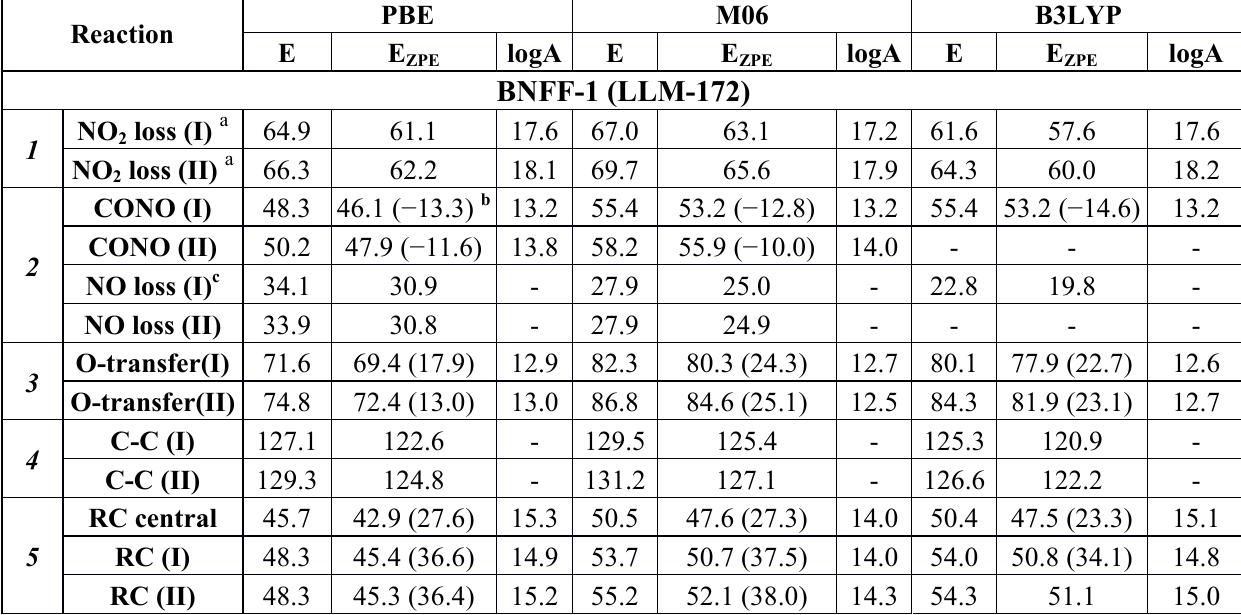
Table 1. Calculated activation barriers E (kcal/mol), zero-point energy corrected barriers, E (kcal/mol), and pre-exponential factors (log(A/ s − 1 )) of BNFF-1 and ANFF-1 ZPE decomposition